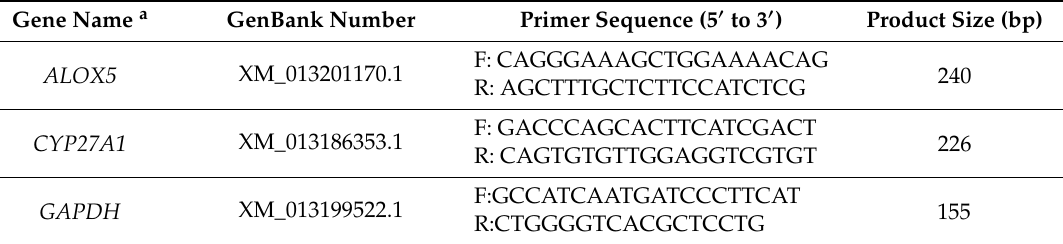
Table 1. Primer sequences for real-time PCR